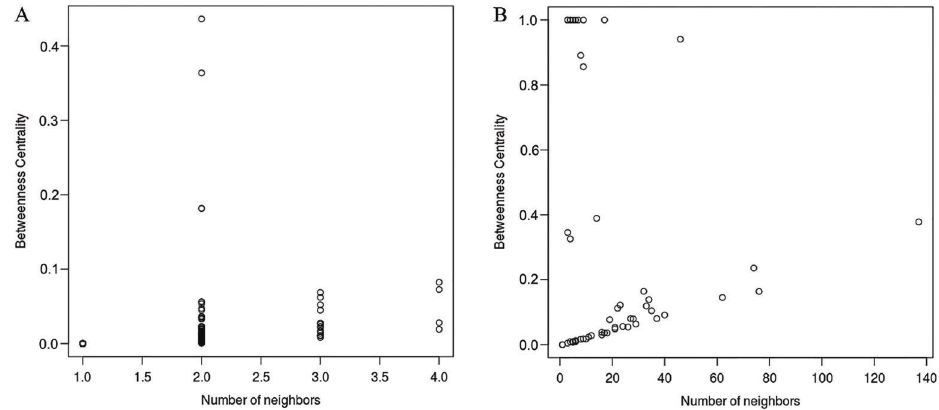
Figure 3. The lncRNA ceRNAs had a higher betweenness centrality than mRNA ceRNAs in the lncRNA-mediated ceRNAs network (LMCN). A , Betweenness distribution of mRNAs in the LMCN; B , Betweenness distribution of lncRNAs of the LMCN.